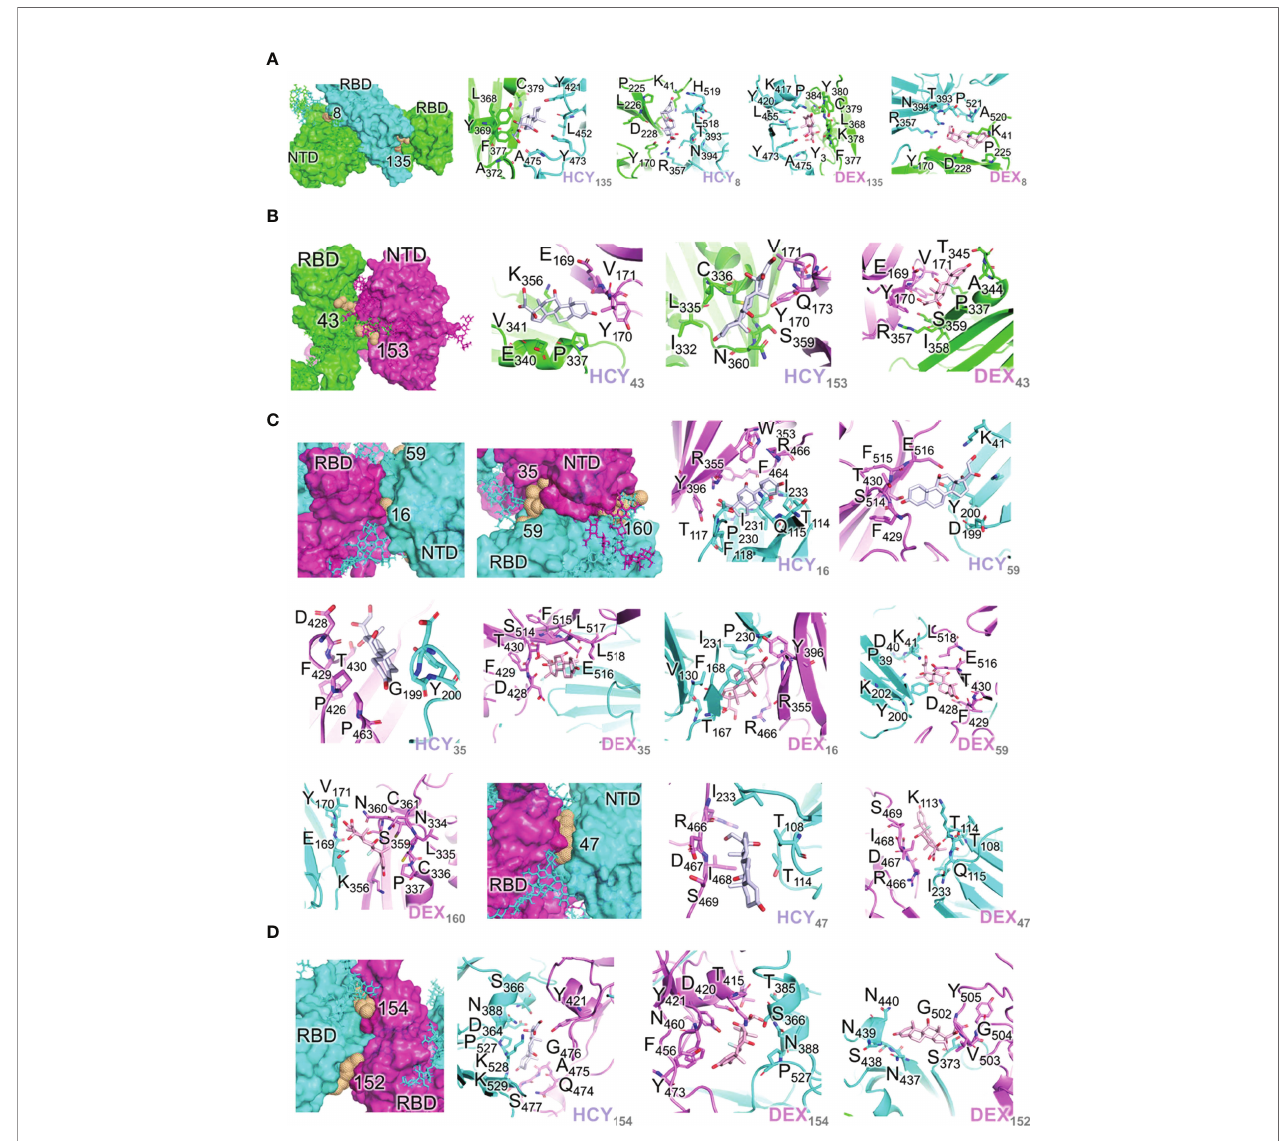
FIGURE 2 | Interactions of the ligand/pocket pairs on the interfaces between chains A, B and C (A) Interactions of the ligand/pocket pairs on the interfaces between chain A (green) and chain B (cyan) of the S1 protein ( Table 4 ). From left to right: High af fi nity binding pockets for cortisol and dexamethasone identi fi ed on the interface; Cortisol pocket 135; Cortisol pocket 8; Dexamethasone pocket 135; Dexamethasone pocket 8. (B) Interactions of the ligand/pocket pairs on the interfaces between chain A (green) and chain C (magenta) of the S1 protein ( Table 4 ). From left to right: High af fi nity binding pockets for cortisol and dexamethasone identi fi ed on the interface; Cortisol pocket 43; Cortisol pocket 153; Dexamethasone pocket 43. (C) Interactions of the ligand/pocket pairs on the interfaces between chain B (cyan) and chain C (magenta) as shown in Table 4 . From left to right: High af fi nity binding pockets for cortisol and dexamethasone identi fi ed on the interface; High af fi nity pockets identi fi ed between NTD of chain C and RBD of chain B; Cortisol pocket 16; Cortisol pocket 59; Cortisol pocket 35; Dexamethasone pocket 35; Dexamethasone pocket 16; Dexamethasone pocket 59; Dexamethasone pocket 160; High af fi nity pocket 47 identi fi ed between the interface of NTD of chain B and RBD of chain C; Cortisol pocket 47; Dexamethasone pocket 47. (D) Interactions of the ligand/pocket pairs on the interfaces between RBD of chain B (cyan) and RBD of chain C (magenta). The binding energies are shown in Table 4 . The pockets where the ligands are predicted to bind with a higher af fi nity (>13 kcal/mole) after MD simulation are shown ( Table 4 ). From left to right: High af fi nity binding pockets for cortisol and dexamethasone identi fi ed on the interface; Cortisol pocket 154; Dexamethasone pocket 154; Dexamethasone pocket